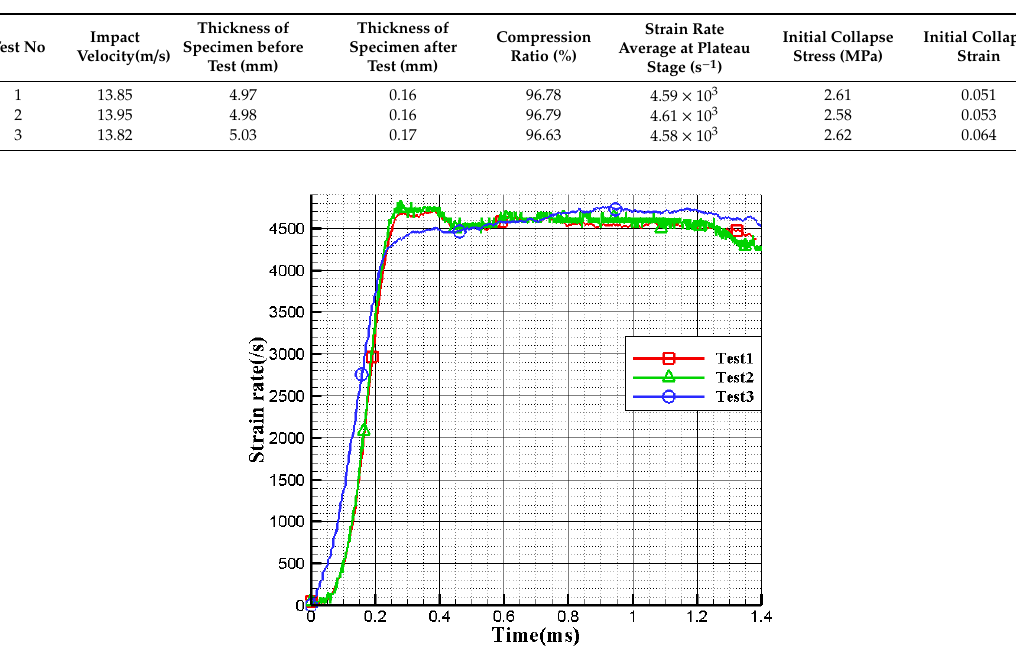
Figure 13. strain rate curve at strain rate 4.6 × 10 3 s − 1 . Figure 13. Strain rate curve at strain rate 4.6 × 10 3 s − 1